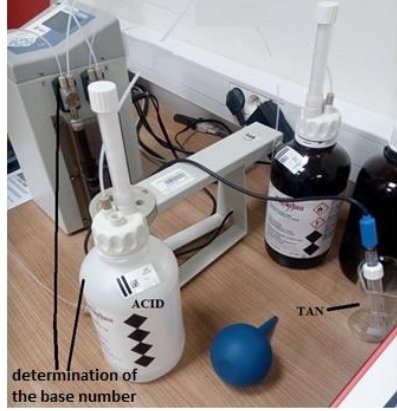
Fig. 2. TitratorTitroMatic 2S device prepared to determine the base number The tests were carried out using samples of the 5W30 fresh and used motor oil according to the ASTM D 2896 standard. Each sample was tested three times and the final result is the mean of these measurements.